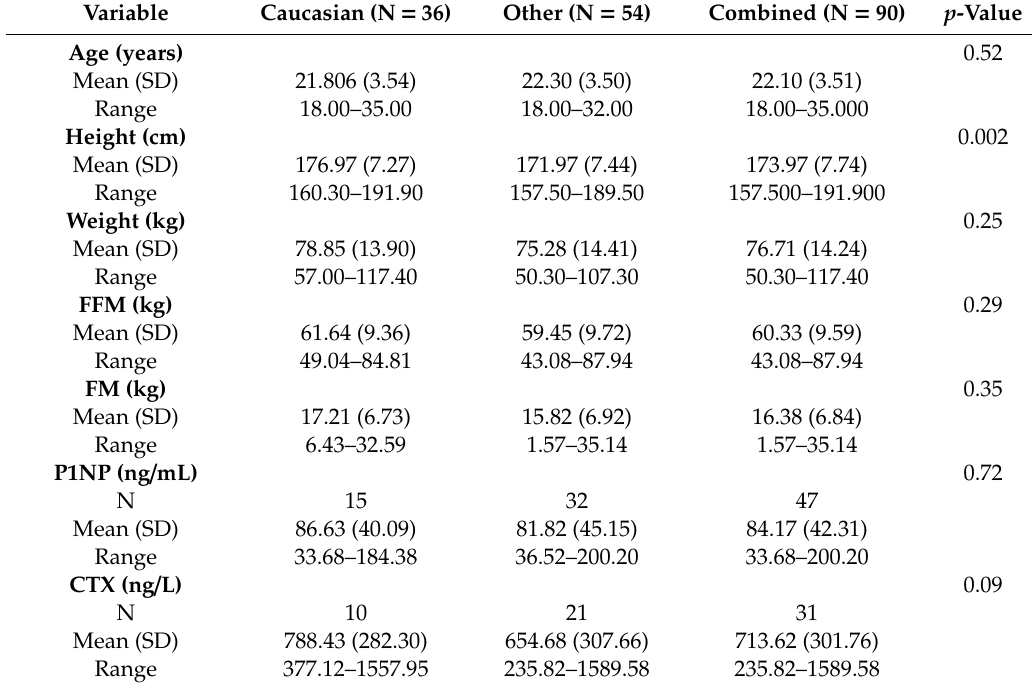
Table 1. Week 1 characteristics by ethnicity.